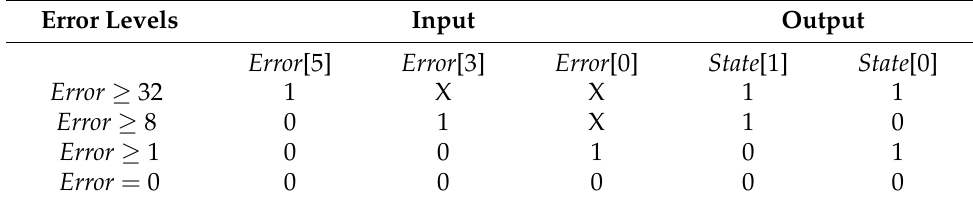
Figure 7. Schematics of the Error Detector A digital sub is introduced to generate the error between the V OUT and V REF . Because the output of the TDC-based converter is thermometer code and the reference voltage is binary, the digital sub contains a encoder to convert the output of the TDC-based converter to binary codes. The entire digital sub is implemented by Verilog and logical synthesis. Four levels for error are shown in Table 1: Error ≥ 32, Error ≥ 8, Error ≥ 1, Error = 0, where the digital code is equivalent to the thermometer code from the TDC-based con- verter output N . And ∆ N = 1 is equivalent to the 25 mV of voltage values. Therefore, the State [1:0] becomes “11” when Error ≥ 0.9 V, and becomes “10” when Error ≥ 0.4 V, and becomes “01” when Error < 0.4 V and becomes “00” when achieve stabilivolt. Depend- ing on Error [5], Error [3], Error [0], the PI controller operates in three groups of coefficient as shown in Table 2. Table 1. State table. 1 means high voltage, 0 means low voltage, X means any voltage.